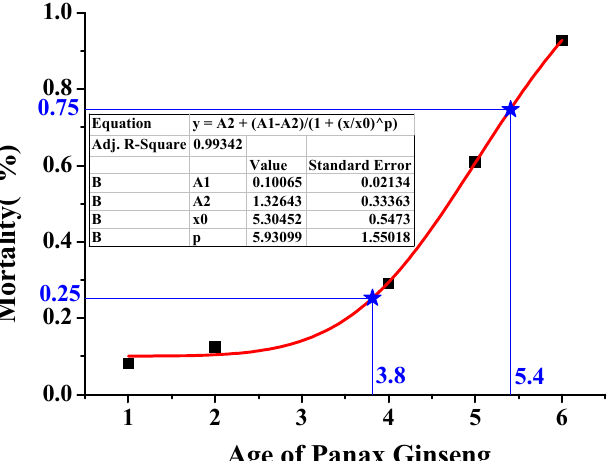
Figure 5. Mortality period of ginseng with R l R l and R h R l genotypes. Ginseng age is on the x -axis and mortality rate is on the y -axis. According to the Hardy–Weinberg equilibrium p2(R h R h )/2pg (R h R l )/q2(R l R l ) ∼ = 1:2:1, the mortality period of the R l R l genotype was roughly determined to be Year 1 to Year 4, the mortality period of the R h R l genotype was from Year 4 to Year 6, and the actual mortality rate was consistent with the predicted